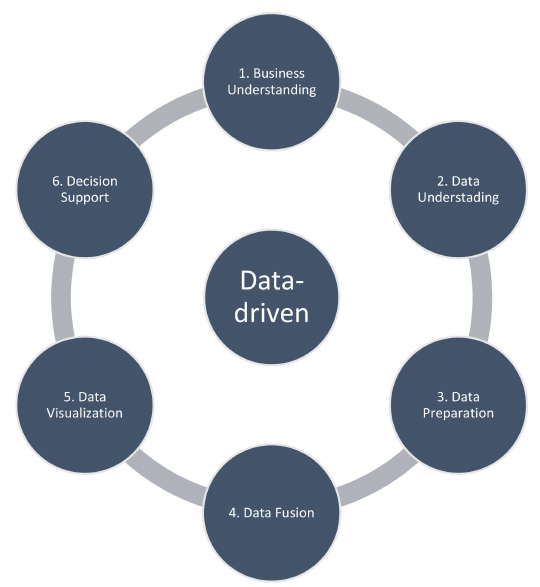
Figure 1. Our data-driven